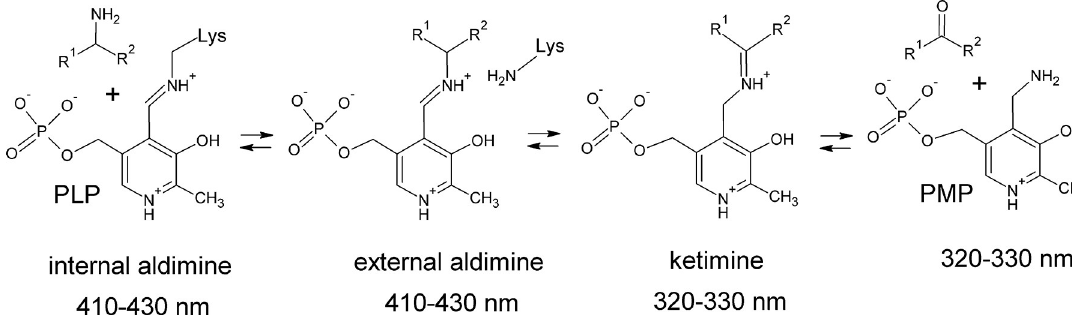
Fig 1. The first transaminase